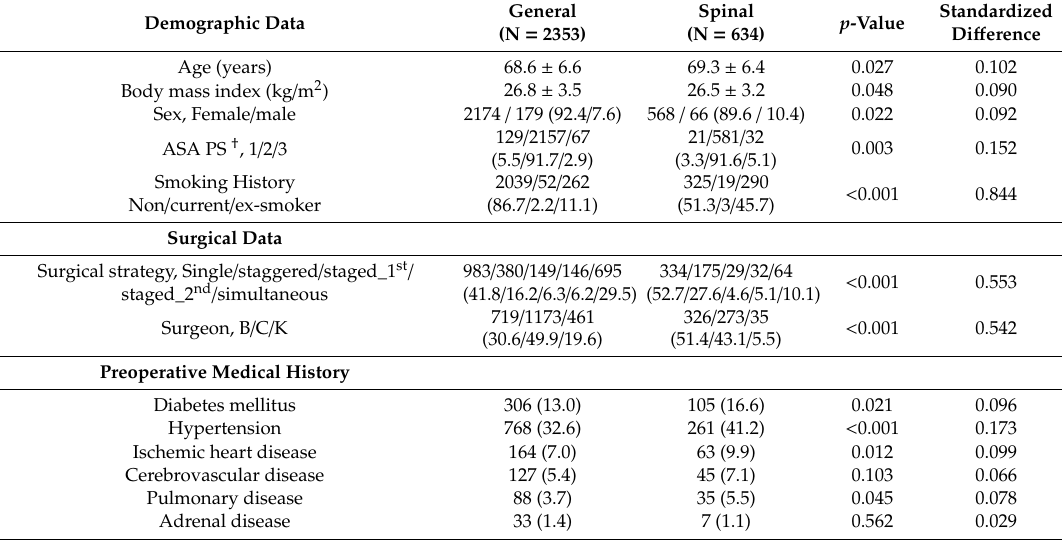
Table 1. Baseline characteristics of all patients included in the total